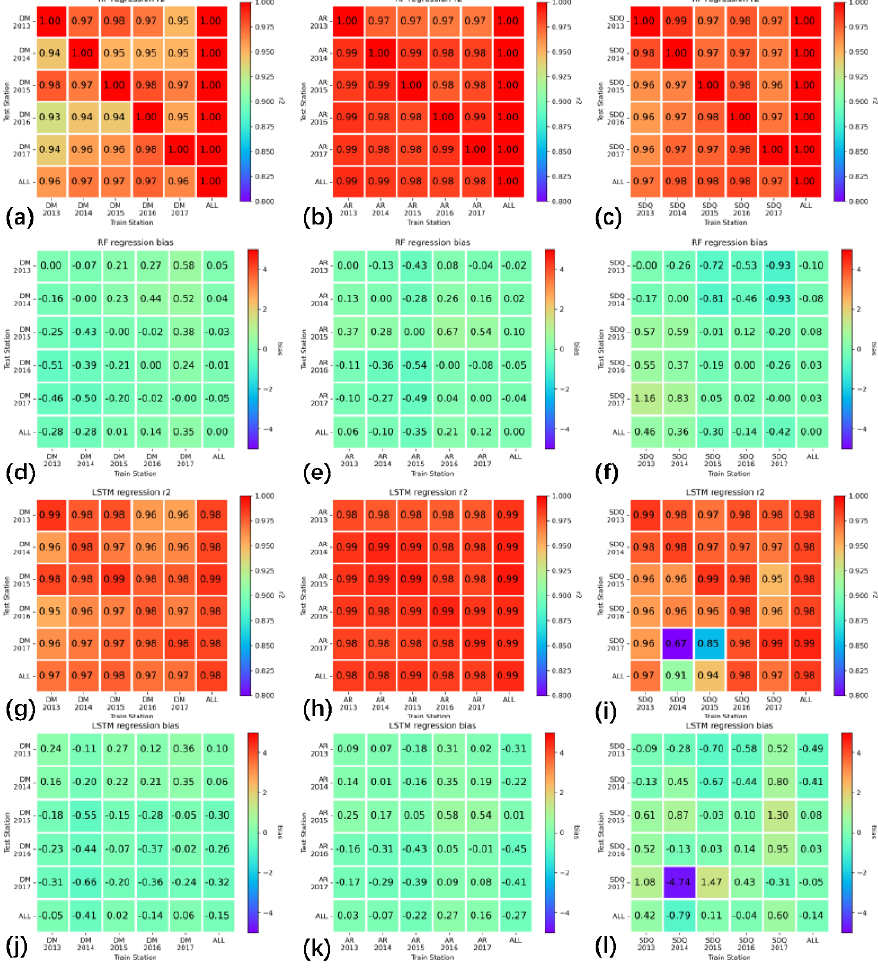
Figure A2. The R 2 and bias of predicted results by RF regression and LSTM method for three super stations with different years. ( a – f ) correspond to the RF method result, R 2 , and bias of DM, AR, and SDQ stations, respectively. ( g – l ) correspond to the LSTM method result, R 2 , and bias of DM, AR, and SDQ stations, respectively.